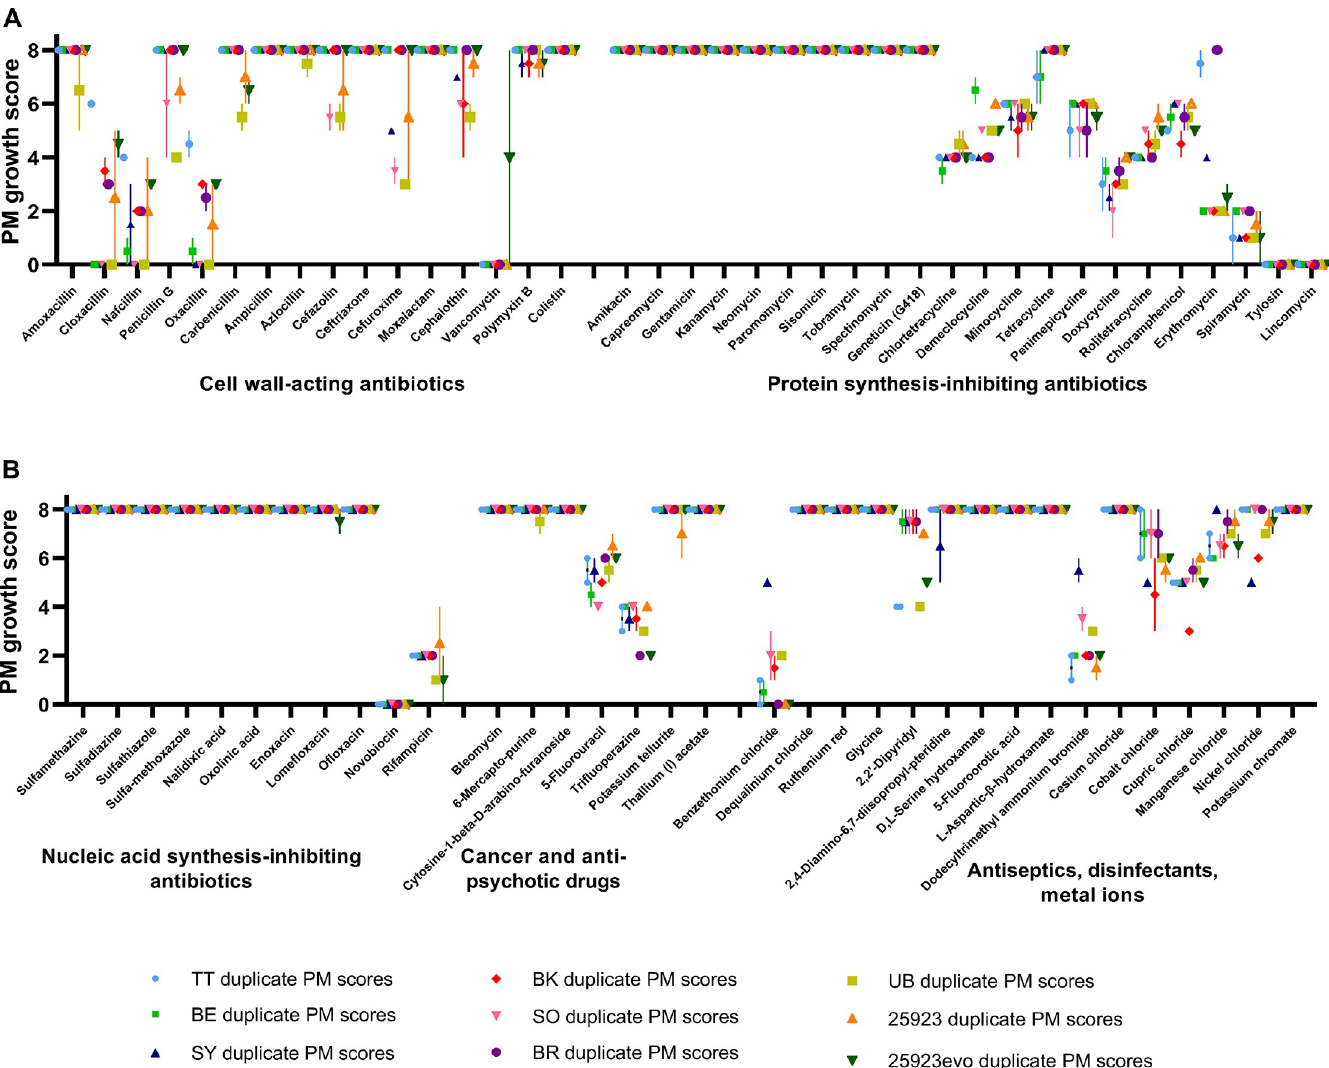
Fig 2. Phenotype Microarray plates yield reproducible resistance/sensitivity data. The plots summarize 1,296 PM growth assays: 72 antimicrobials × 9 S . aureus strains, each done in biological duplicate. (A) Scores of each strain in response to cell-wall acting antibiotics and protein synthesis inhibitors. (B) Scores in response to nucleic acid synthesis inhibitors, cancer and antipsychotic drugs, and antiseptics, disinfectants and metal ions. Each symbol represents the median PM growth score, with the error bars showing the range of the two scores. In 544 of 648 antimicrobial/strain combinations, scores were identical in duplicate assays. In only 29 cases do the error bars span more than one point on the 8-point